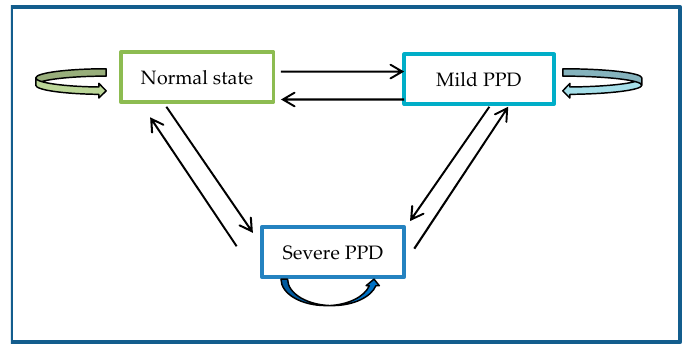
Figure 2. Three PPD state transitions in the Markov model.